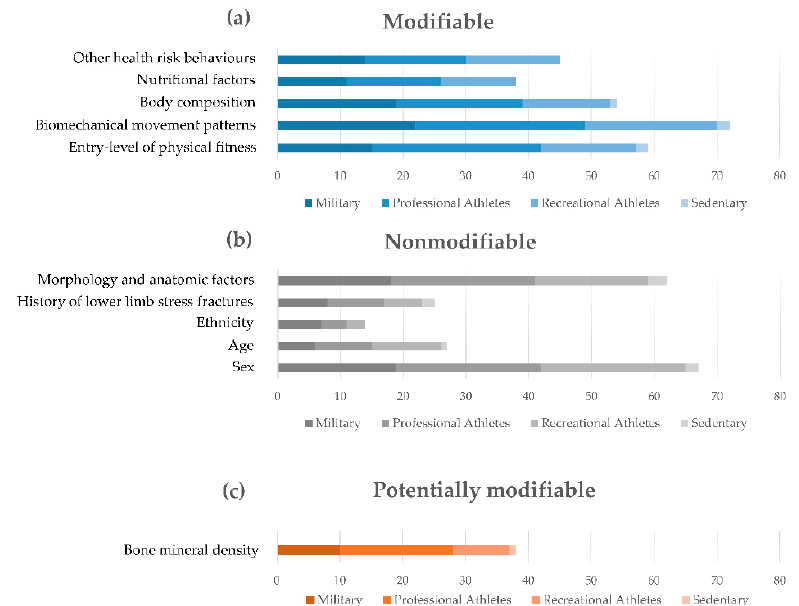
Figure 7. Reviewed articles regarding modifiable ( a ), nonmodifiable ( b ) and potentially modifiable ( c ) intrinsic risk factors according to the investigated population.